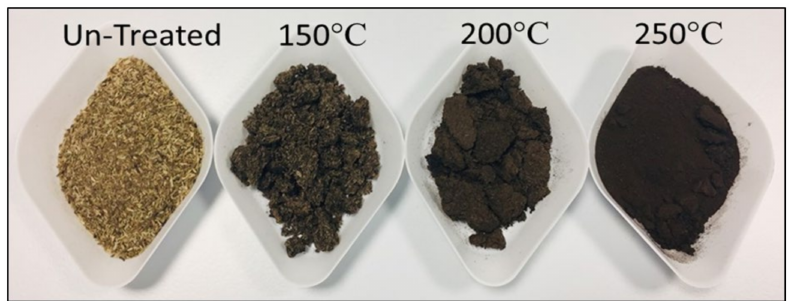
Figure 2. Images of untreated water hyacinth (WH) and hydrochars produced from WH during hydrothermal carbonisation at 150 ◦ C, 200 ◦ C, and 250 ◦